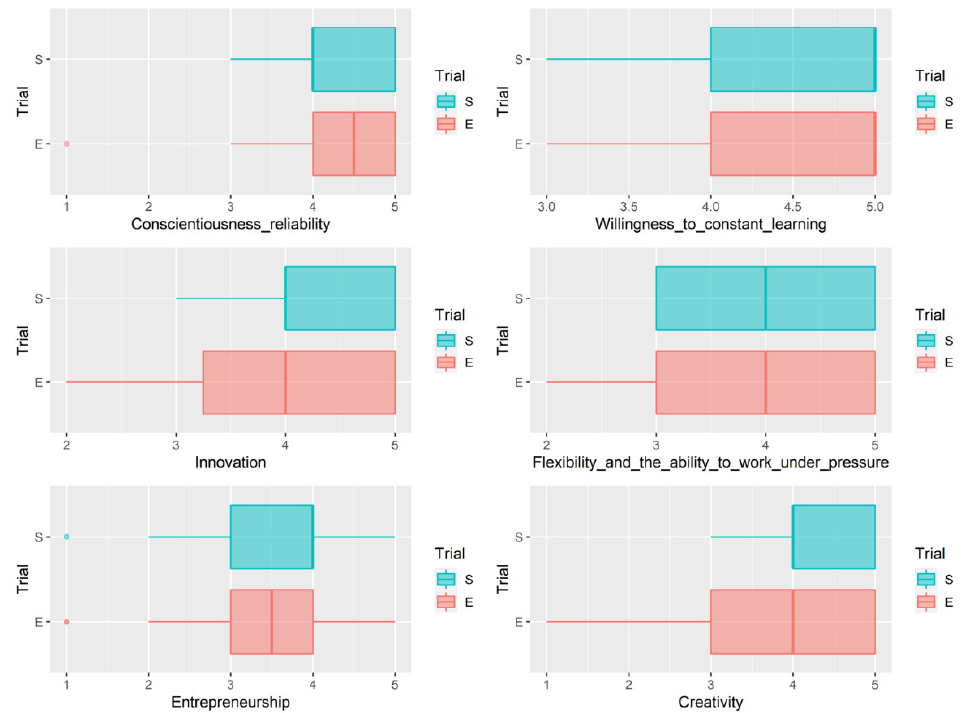
Figure 5. Assessments of personal competencies in the trials (1—not important, 5—very important). Source: own elaboration.